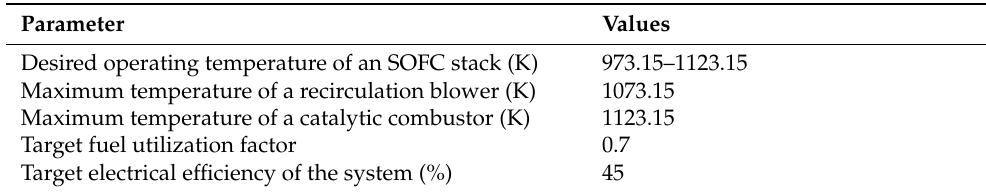
Table 5. Restrictions and target performances of the SOFC system in this